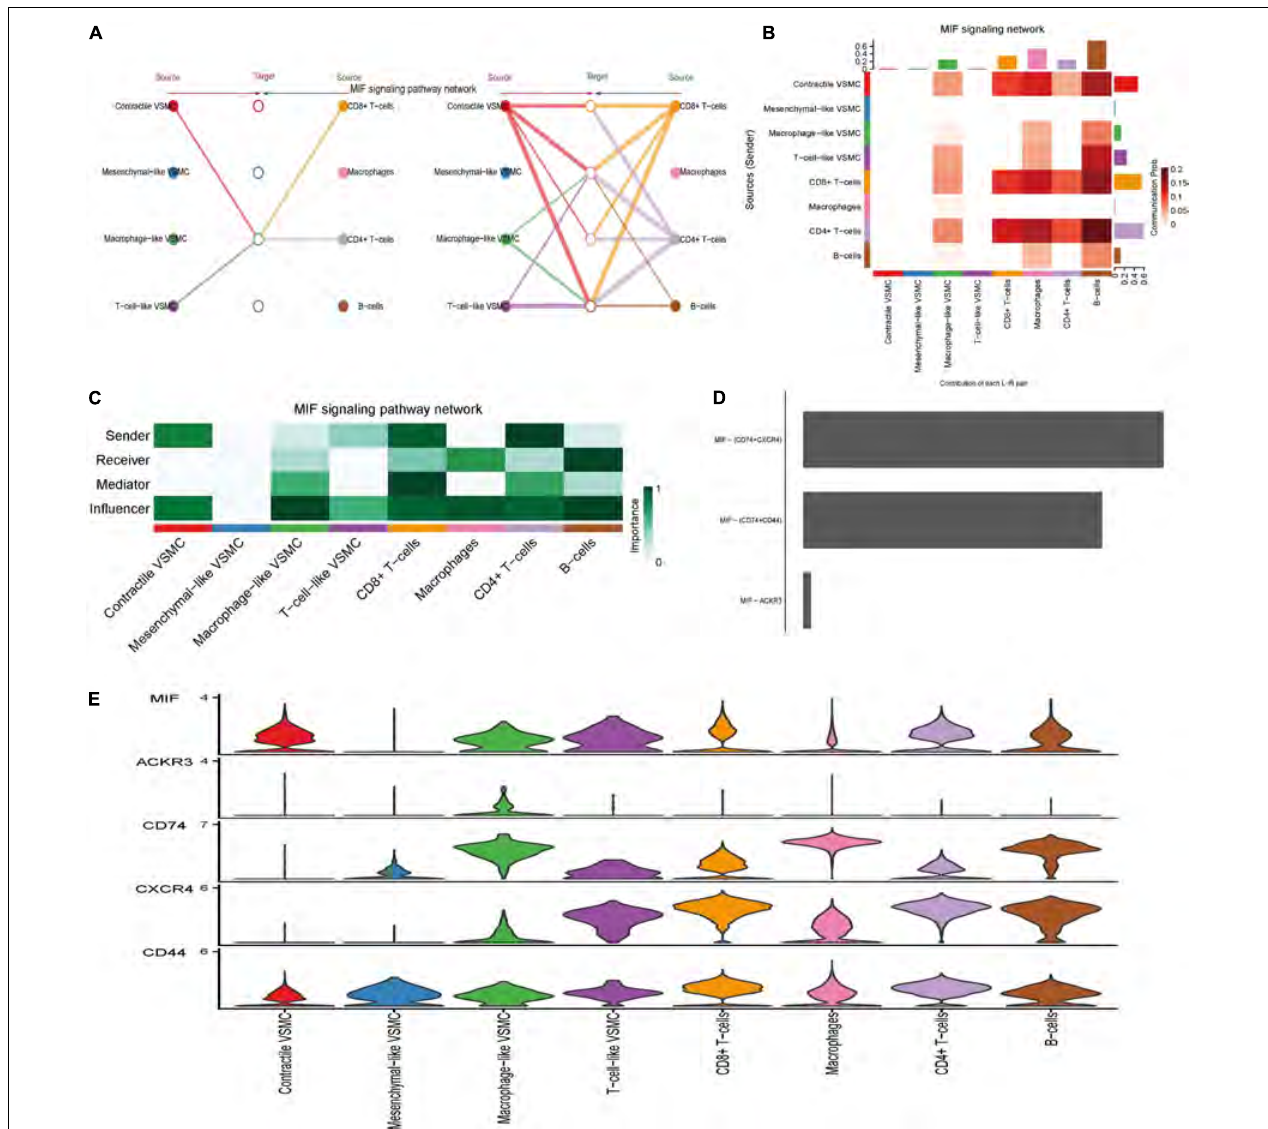
FIGURE 5 | MIF signaling pathway-mediated intercellular communication intensity is shown in the hierarchy plot (A) and heatmap (B) . Network center score showed the role each cell type played, including sender, receiver, mediator, and influencer (C) . Contribution of each ligand–receptor pair to MIF signaling (D) . Expression level of every ligand and receptor gene in each cell type (E)